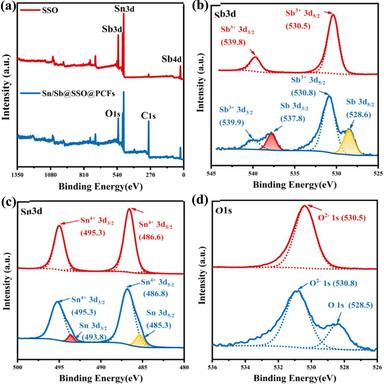
Compare of XPS spectra for the Sn/Sb@SSO@PCFs (blue) and bare SSO (red); (a) full spectrum in the measurement range; high-resolution XPS of different elements: (b) Sb3d; (c) Sn3d; and (d) O1s.